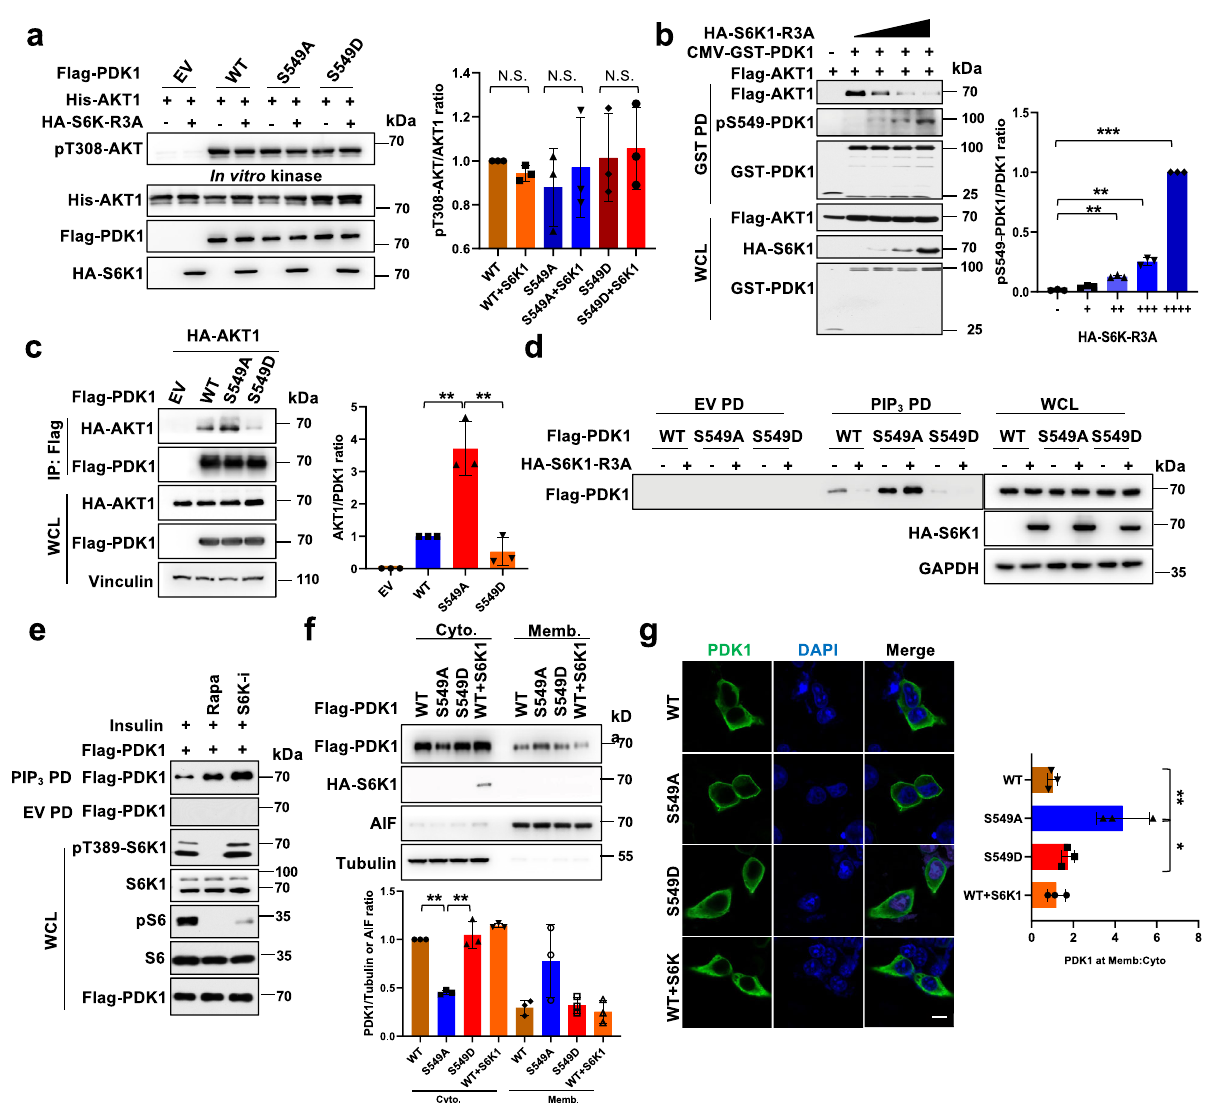
Fig. 3 S6K1-mediated phosphorylation of PDK1 inhibits PDK1 membrane localization and PIP3 binding. a The indicated Flag-PDK1 constructs with/ without HA-S6K1-R3A were transfected into 293 T cells and anti-Flag immunoprecipitation was recovered as the kinase source to phosphorylate insect cells puri fi ed His-AKT1 in vitro. pT308-AKT/AKT1 ratio were calculated. (mean± SD, n = 3). b IB analysis of WCL and GST-pulldown derived from 293 T cells transfected with GST-PDK1, Flag-AKT1 and increasing dose of HA-S6K1-R3A. pS549-PDK1/PDK1 ration were calculated. (mean ± SD, n = 3, P = 0.0001, 0.0002, 7.82E-10). c IB analysis of WCL and IP products derived from 293 T cells transfected with Flag-PDK1(WT, S549A, S549D) and HA- AKT1. Indicated protein were quanti fi ed. (mean ± SD, n = 3, P = 0.005, 0.004). d IB analysis of PIP 3 pull-down products and WCL derived from 293 T cells transfected with the indicated constructs. Where indicated, empty beads (EV) serve as a negative control. e IB analysis of PIP 3 pull-down products and WCL derived from HeLa cells transfected with Flag-PDK1 that were serum-starved for 24 h and then collected after insulin (100 nM) stimulation for 30 min, where indicated, the kinase inhibitors were added. f IB analysis of cell fractionations separated from 293 T cells transfected with indicated constructs. PDK1/Tubulin or AIF ratio were calculated. (mean ± SD, n = 3, P = 2.98E-06, 0.002). g Representative immuno fl uorescence images of 293 T cells transfected with indicated constructs, scale bar, 10 μ m. Mean PDK1 fl uorescence intensity at plasma membrane relative cytosol was determined, data represent mean ± SD, P = 0.008, 0.03. Greater than 60 cells were analyzed from 3 independent experiments. Similar results were obtained in n ≥ 3 independent experiments in d , e . Statistical signi fi cance was determined by two-tailed Student ’ s t -test in b , c , f . g N.S > 0.05, * P < 0.05,** P < 0.01. Source data are provided in Source Data fi les. EV, empty vector. WCL, whole cell lysate. IP, immunoprecipitation. WT, wild type. PD, pulldown. Cyto, cytoplasm. Memb,